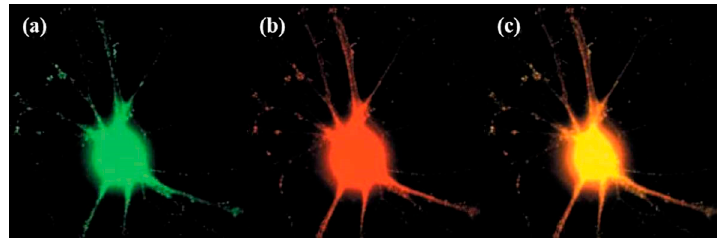
Figure 11. Cortical neurons expressing brain-derived neurotrophic factor (BDNF): ( a ) with green fluorescence protein after 24 h of delivery; ( b ) stained with anti-BDNF antibody; ( c ) merge image of both green fluorescence protein and anti-BDNF antibody. Reprinted with permission from [148].